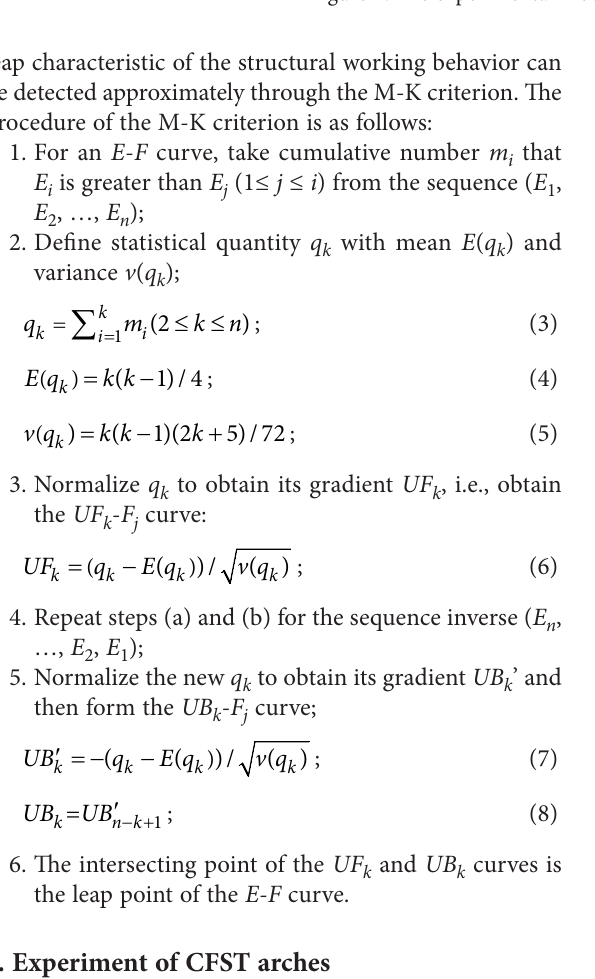
Table 1. The configurational parameters of the experimental Loading